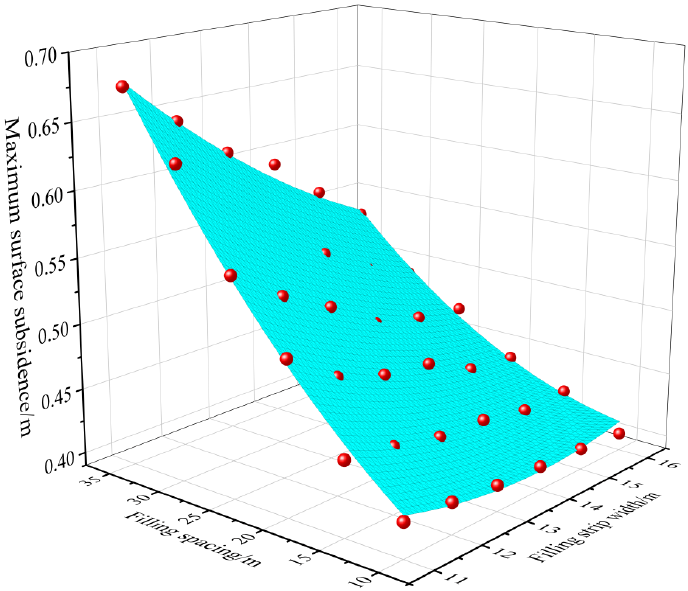
Figure 11. Fitting surface of the maximum surface subsidence with different filling spacings and filling strip